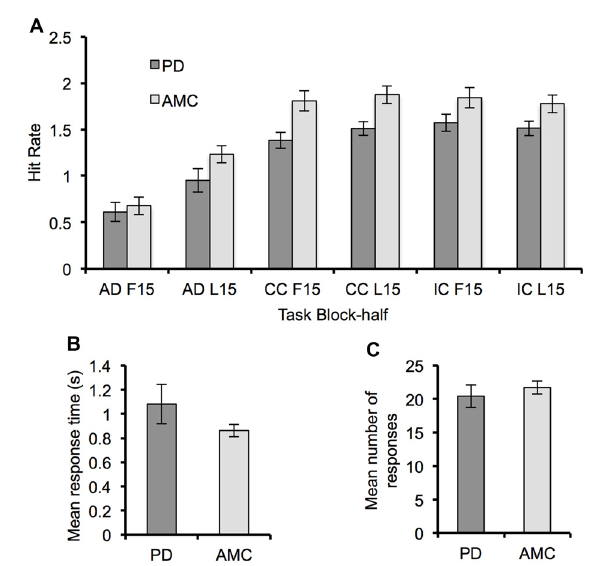
FIGURE 2 | Behavioral performance for the Parkinson’s disease (PD) and AMC groups. (A) The hit rate for each block-half (F15, L15) of the AD task, the CC task, and the IC task, showing a general improvement in performance across all tasks. (B) Mean response time and (C) mean number of responses from the SR task for each group. Overall behavioral performance across the two groups was similar. Error bars indicate standard error.